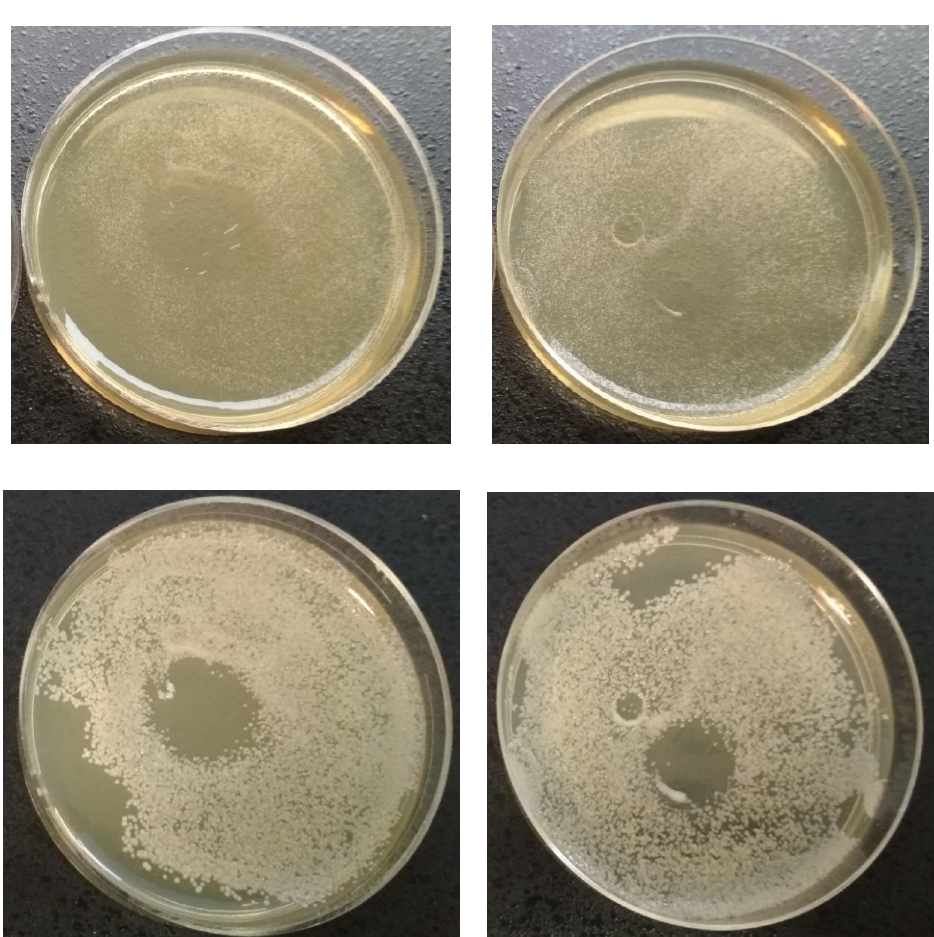
Figure 8. Comparison of the regrowth after the 24 h ( top ) and 48 h ( bottom ) cultivation of the 10-fold dilution after the 2 min treatment with the use of 9 W ( right ) or 12 W ( left ) power.